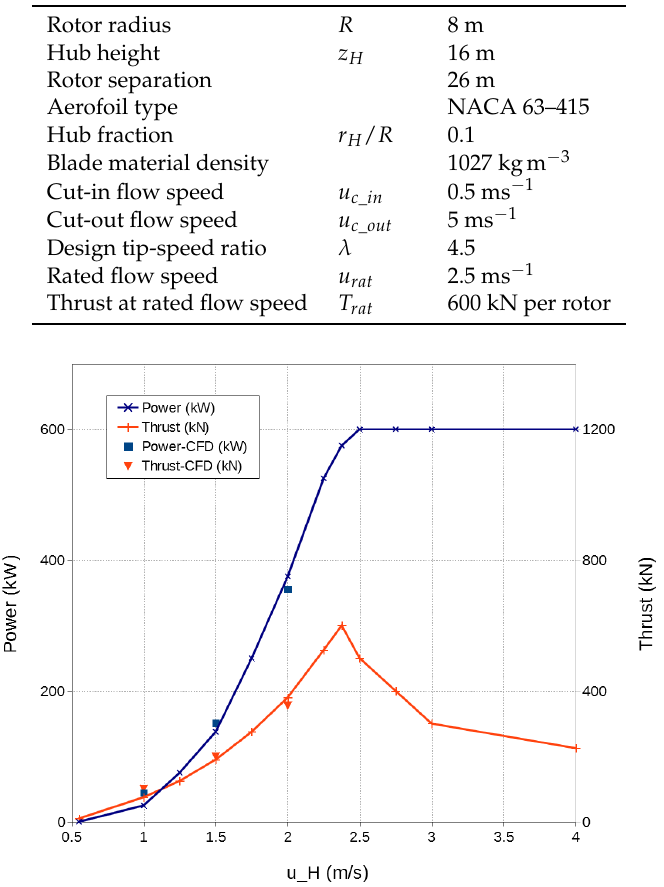
Figure 9. Time-averaged power (blue) and thrust (red) for a single rotor of SeaGen, as a function of mean hub-height flow speed u H . The solid lines represent data sourced from Douglas et al. [63] and Fraenkel et al. [53,61]; the squares and triangles represent simulation